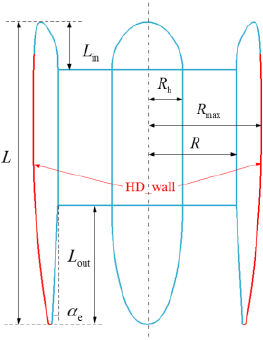
Figure 2. Schematic diagram of the duct profile.